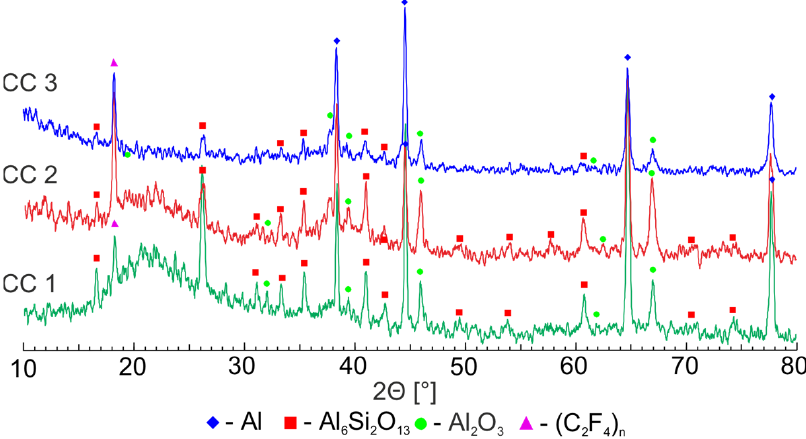
Figure 4. XRD patterns of composite coatings formed on aluminum alloy.